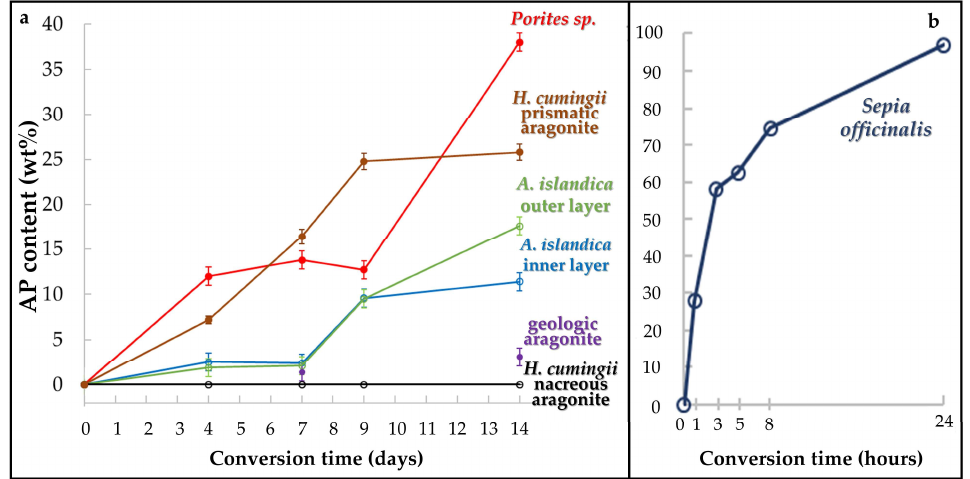
Figure 1. Newly formed apatite content of all samples relative to conversion time according to Rietveld analyses of the XRD measurements ( a ) 14 days H. cumingii nacre (brown line) and prismatic aragonite layer (black line), A. islandica outer (green line) and inner layer (blue line), geologic aragonite (violet data points) and Porites sp. (red line); ( b ) Sepia officinalis , conversion time 1–24 h. Error for H. cumingii nacre and Sepia officinalis is within the size of the corresponding data points.